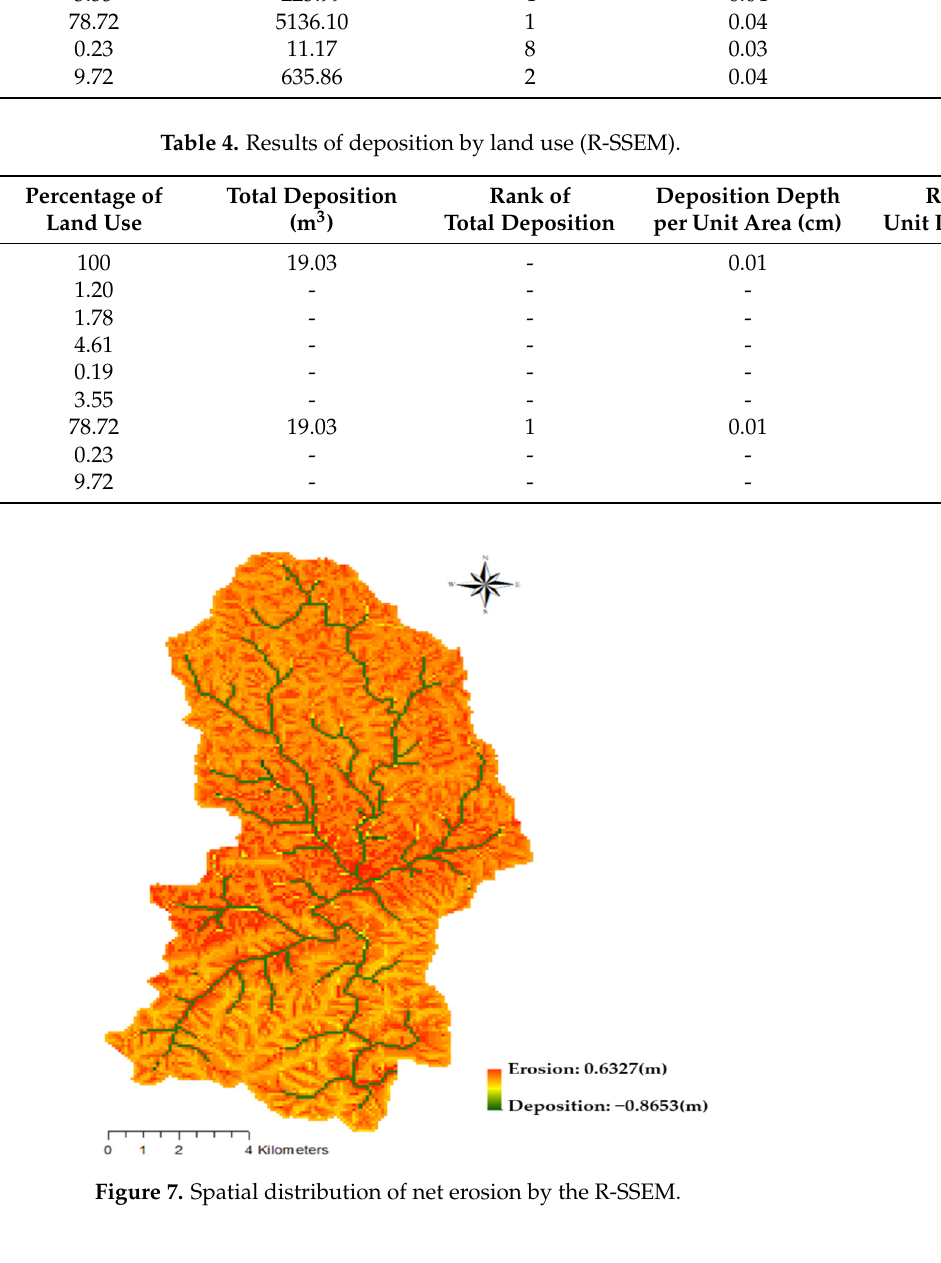
Figure 8. Effective soil depth of the study area.